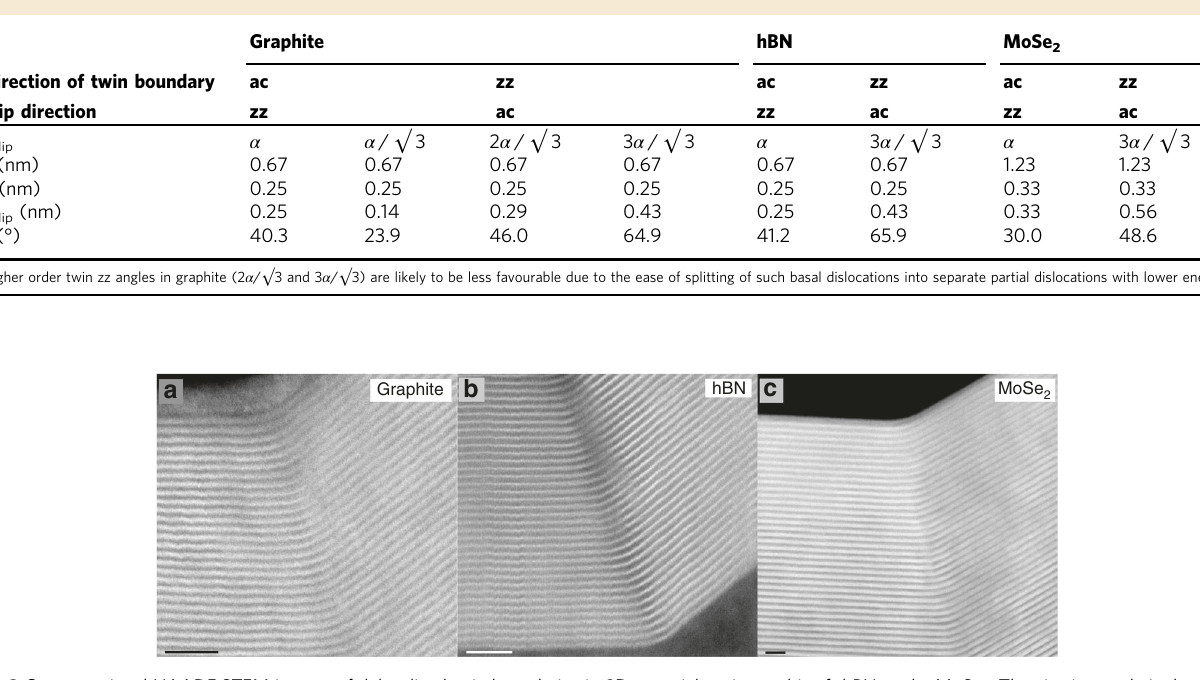
Fig. 2 Cross-sectional HAADF STEM images of delocalised twin boundaries in 2D materials. a in graphite; b hBN; and c MoSe 2 . The viewing angle is down the armchair direction for all materials. This geometry is seen repeatedly in graphite kink bands as well as in vdW materials with different stacking preferences, interlayer adhesion and bending moduli. The bend angle in each material is dependent on its crystal lattice parameters (Table 1). All scale bars